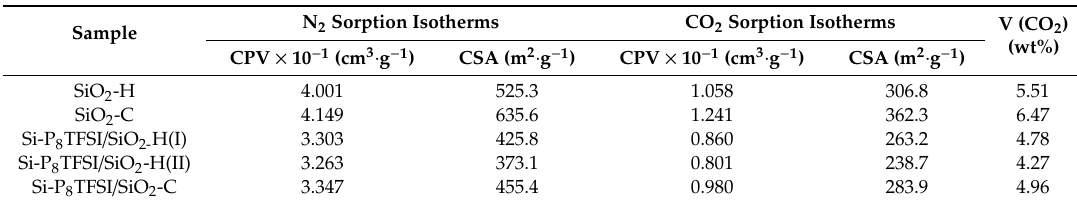
Table 2. Pore structure parameters of samples based on N 2 sorption isotherms at − 196 ◦ C and CO 2 sorption isotherms at 0 ◦